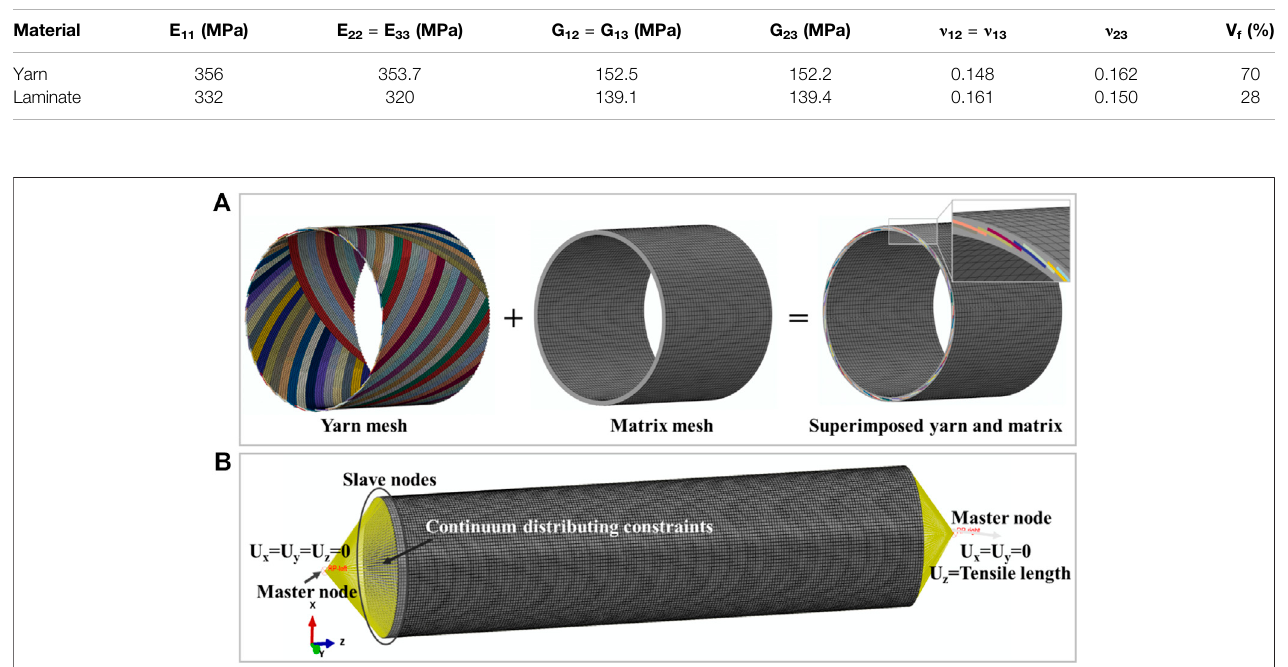
FIGURE 8 | (A) De fi ne the constraints between the yarn and the matrix by domain superposition technique; (B) displacement constraints at both ends of the tube.